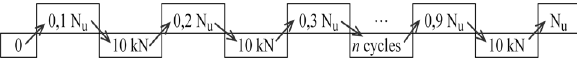
Fig. 3. Schematically presented investigative procedure